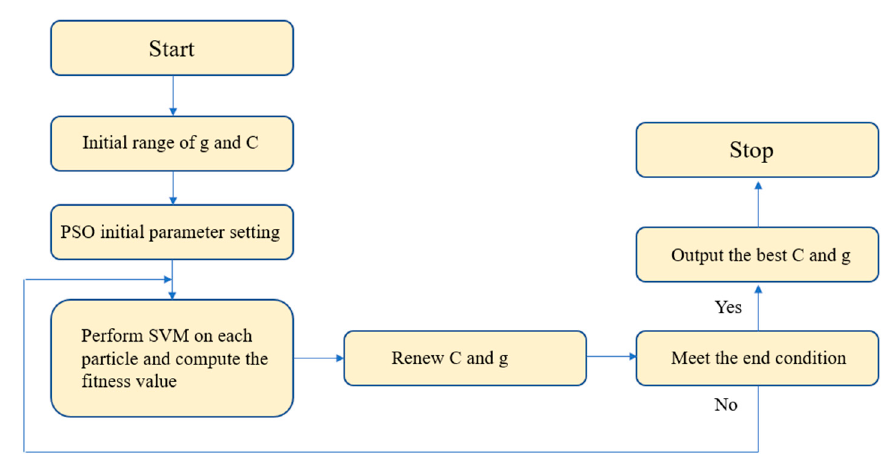
Figure 4. PSO flow Figure 4. PSO flow chart.